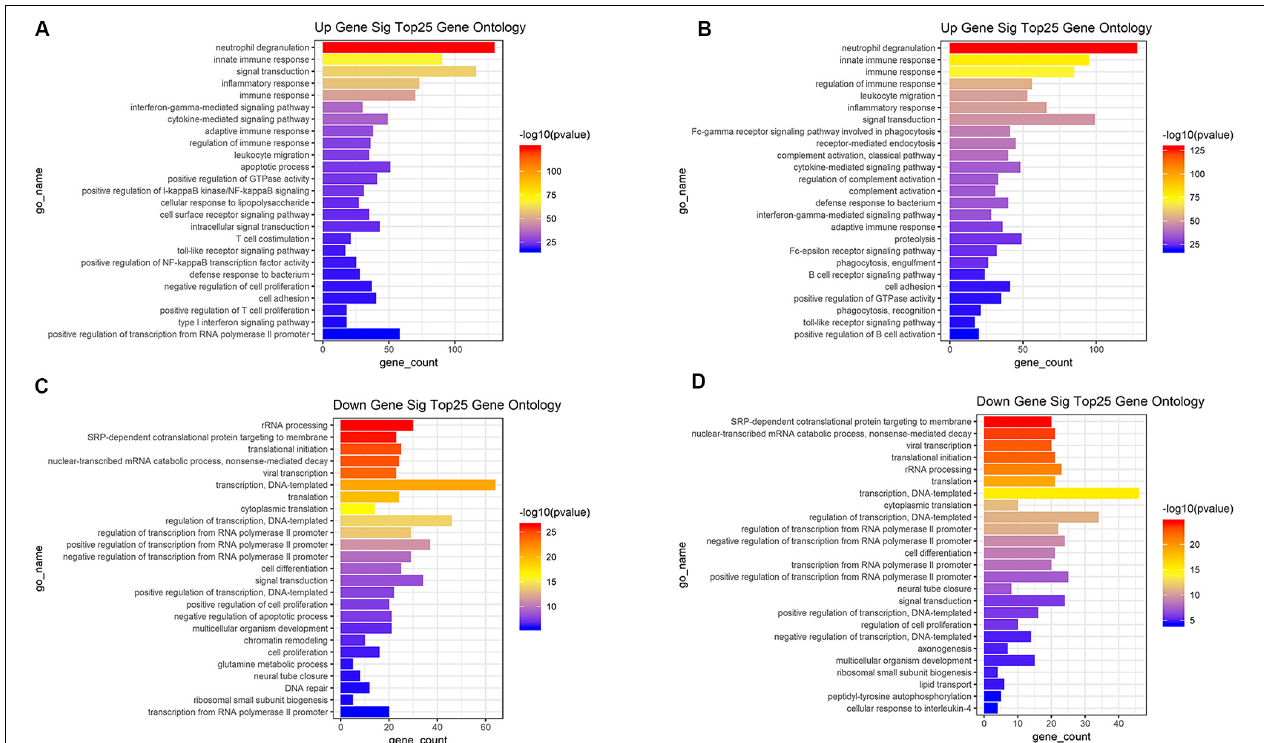
FIGURE 3 | Top 25 GO terms in each of biological process were performed for functional enrichment clustering analysis. (A) Top25 significant GO terms based on upregulated genes in immune scores. (B) Top25 significant GO terms based on upregulated genes in stromal scores. (C) Top25 significant GO terms based on downregulated genes in immune scores. (D) Top25 significant GO terms based on downregulated genes in stromal scores. GO, gene